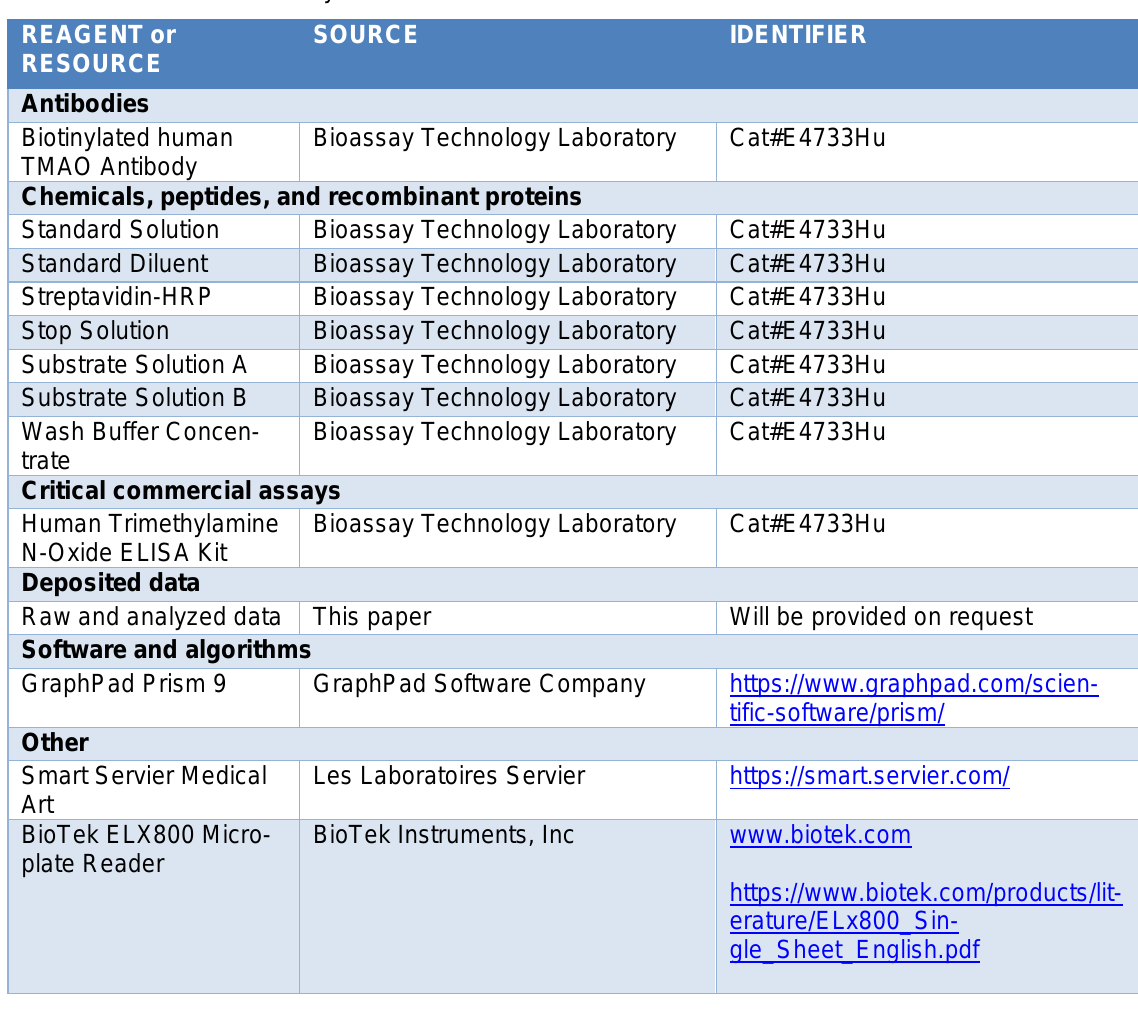
Table 1: STAR METHOD key sources table REAGENT